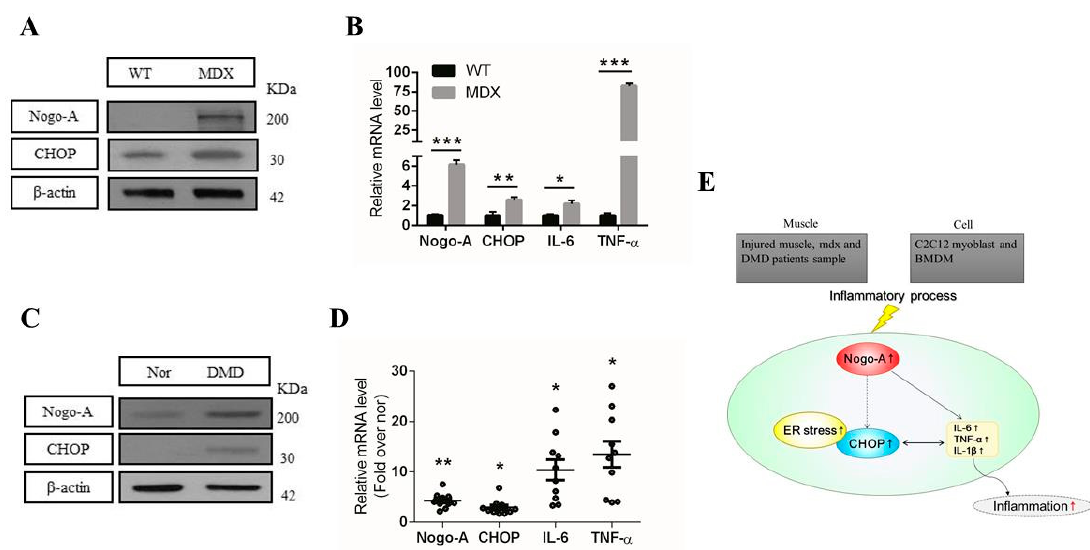
Figure 7. Nogo-A, CHOP, and pro-inflammatory factors are upregulated in mdx mice and Duchenne muscle dystrophy (DMD) patient samples. ( A ) IB analysis of Nogo-A, CHOP, and β -actin in the skeletal muscle of WT and mdx mice. ( B ) qPCR analysis of mRNA from the skeletal muscle of 12-week-old WT and mdx mice ( n = 4). ( C ) Tissue extracts from DMD and myopathy patients and normal subjects were used in the IB analysis with Nogo-A, CHOP, and β -actin antibodies. ( D ) The qPCR analyses were performed on biopsy samples of DMD and myopathy patients and normal subjects. ( E ) Proposed model of the role of Nogo-A in the regulation of inflammation. Nogo-A is activated in muscle from notexin-treated mice, mdx mice, DMD patients and in LPS-treated BMDM. Subsequently, Nogo-A expression may be accompanied by CHOP activation and can also activate pro-inflammatory cytokines and chemokines in injured or degenerated muscle and in LPS-stimulated BMDM. We conclude that Nogo-A exerts inflammatory effects. In all, 40 µ g of protein was used for the IB experiments. The statistical significance was determined using Student’s t -test. Error bars represent the standard error of the mean. Data are denoted by asterisks where * p < 0.05, ** p < 0.01, and *** p < 0.001.